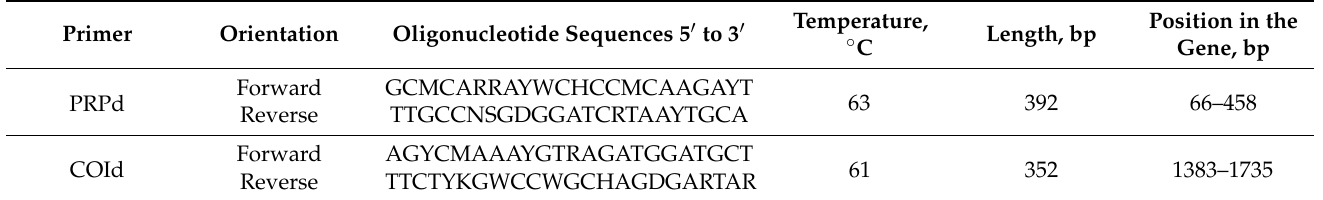
Table 1. Selected primer pairs with degenerate nucleotides for PR and COI